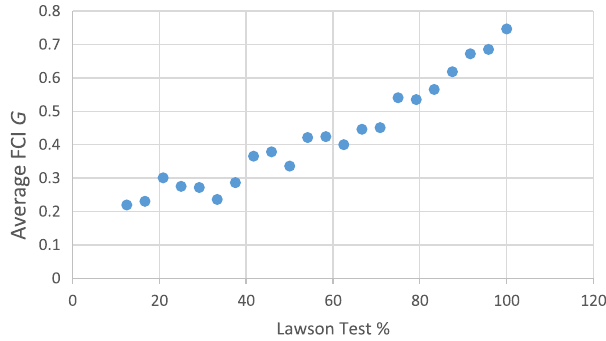
FIG. 5. Average FCI normalized gain for each Lawson score from a sample of 1432 individual G ’ s and Lawson scores; standard error for each average ¼ 0 . 02 − 0 . 04